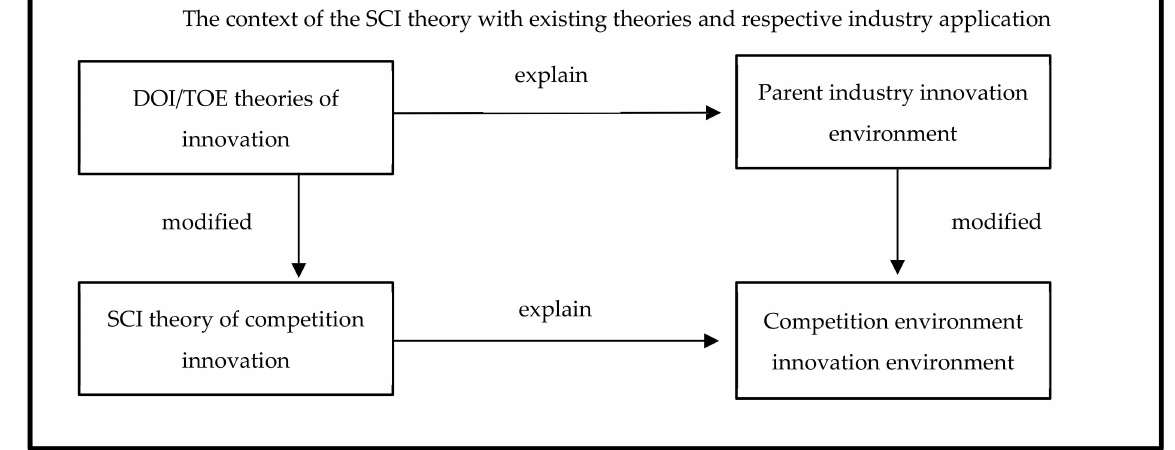
Figure 6. Revisiting the context of the SCI